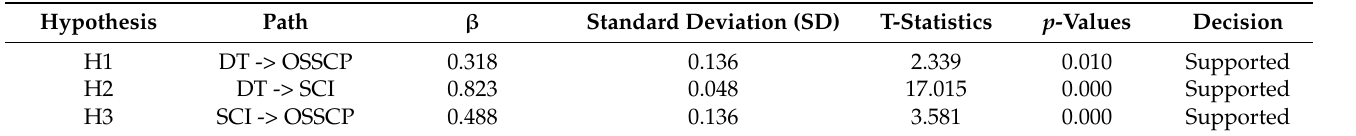
Table 6. Hypothesis testing.